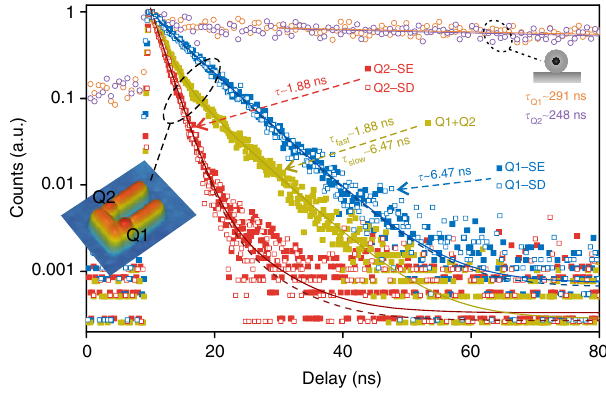
Fig. 4 Lifetime measurements under different excitation and detection conditions. Q1-SE (blue solid data points and blue solid fi tting curve): Q1 selectively excited, without selective detection; Q2-SE (red solid data points and red solid fi tting curve): Q2 selectively excited, without selective detection; Q1 + Q2 (yellow-green solid data points and yellow-green solid fi tting curve): Q1 and Q2 equally excited, without selective detection; Q1-SD (blue hollowed data points and blue dashed fi tting curve): Q1 and Q2 equally excited, Q1 selectively detected; Q2-SD (red hollowed data points and red dashed fi tting curve): Q1 and Q2 equally excited, Q2 selectively detected. The lifetimes are remarkably reduced compared with that of Q1 (orange hollowed) and Q2 (purple hollowed) before they couple to the gold